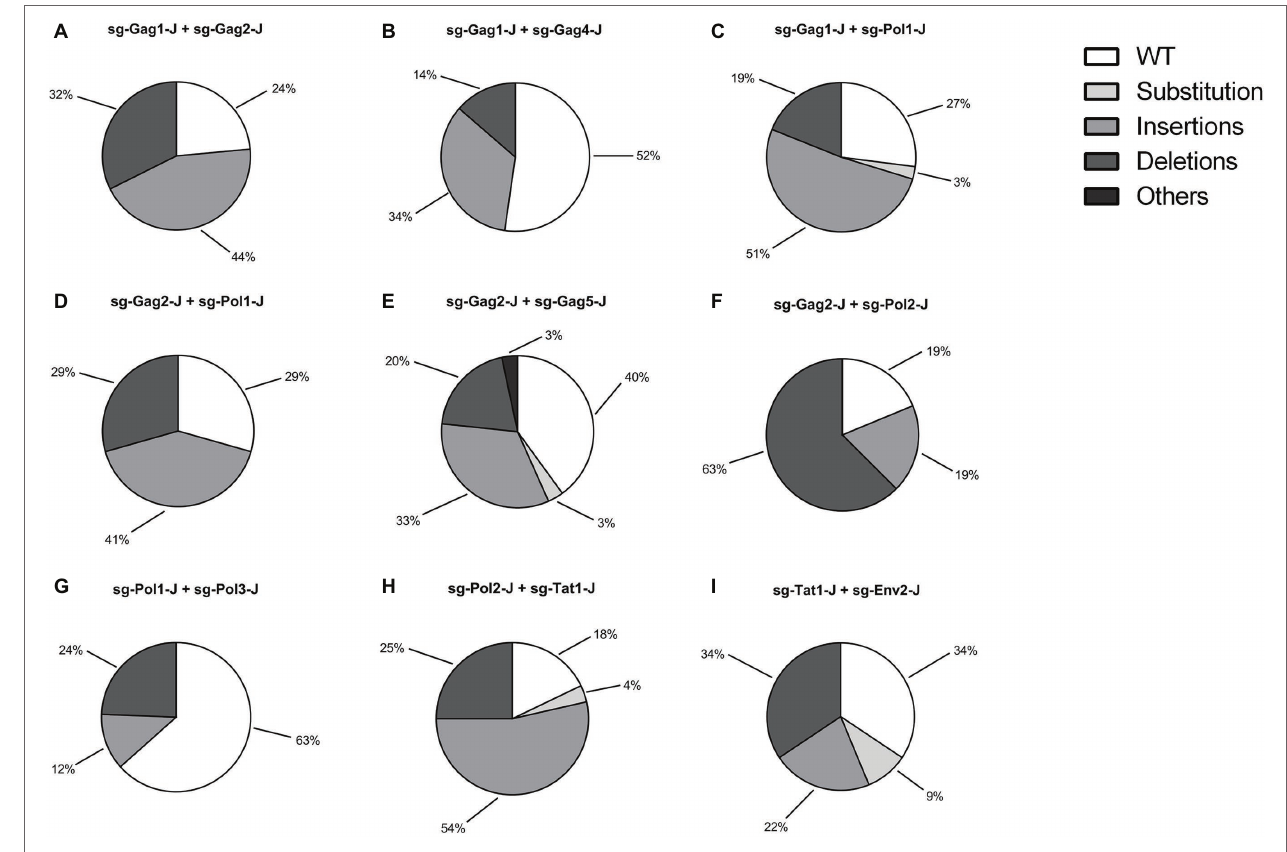
FIGURE 3 | Genotypic Analysis of dual-sgRNAs/Cas9 Targeted HIV-1 DNA. (A–I) The types and frequency of mutations dual-sgRNAs/Cas9-treated in J-Lat 10.6 cells are shown. sgRNA target regions with simultaneous nucleotide substitutions (NSs) and an insertion/deletion were counted as an